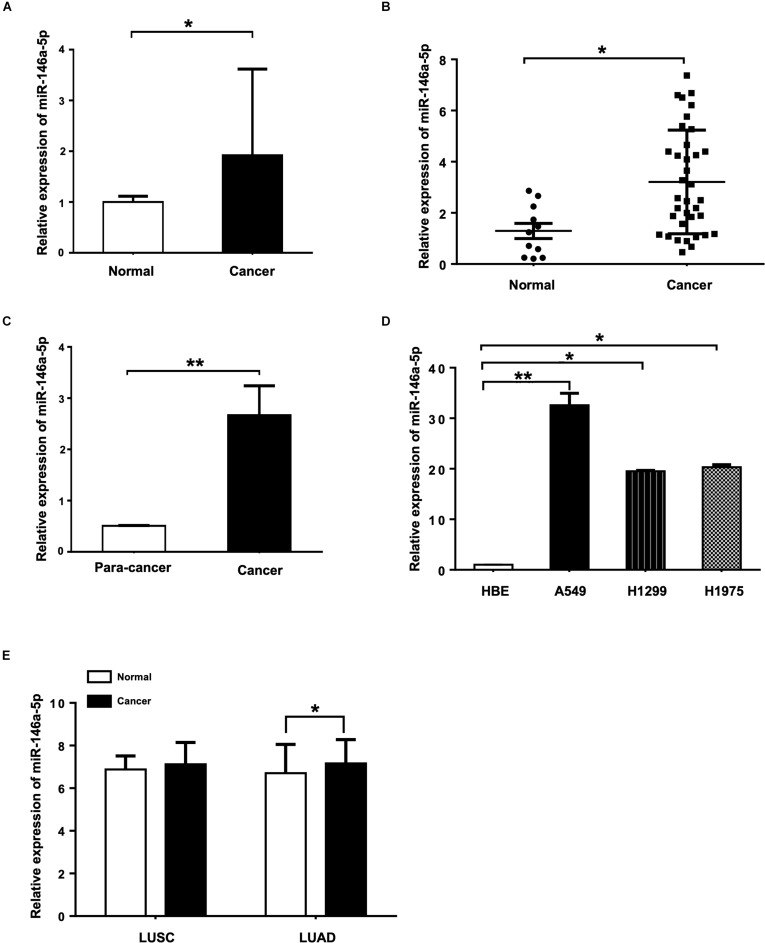
miR-146a-5p expression is up-regulated in NSCLC tissues, serum samples and cell lines. (A) Expression of miR-146a-5p in NSCLC patient and normal serum samples measured by miRNA Solexa sequencing. (B) qRT-PCR validation of the result from (A). (C) Expression of miR-146a-5p in NSCLC cancer and corresponding para-cancer tissues determined by qRT-PCR. (D) Expression of miR-146a-5p in three NSCLC cell lines (A549, H1299 and H1975) and human bronchial epithelium cell line (HBE) determined by qRT-PCR. (E) Expression of miR-146a-5p from TCGA. LUSC: lung squamous cell carcinoma, LUAD: lung adenocarcinoma.